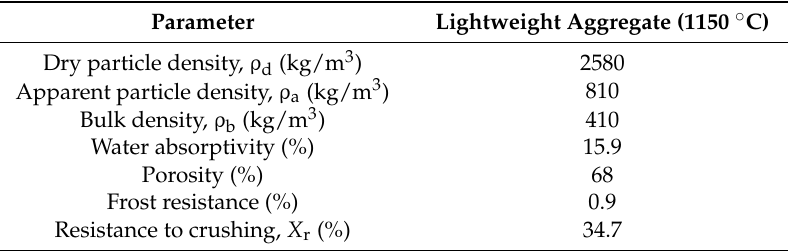
Table 3. Physical and mechanical properties of the lightweight aggregate burnt at a temperature of 1150 ˝